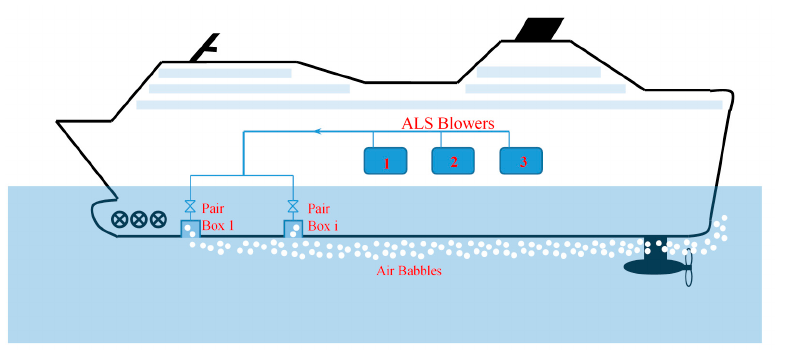
Figure 4. Diagram of the system of introducing the air layer under the hull bottom of the passenger vessel-Air Lubrication System (ALS). High-capacity blowers are used to generate air bubbles that flow at a constant speed under bottom of the hull. The air bubble outlets are located along the bottom of the hull, symmetrically on both sides of the ship’s center line [13,23]. A schematic diagram of the ALS with two blowers, distribution line of compressed air and with air distribution boxes on a large passenger vessel (cruise liner) is presented in Figure 5.